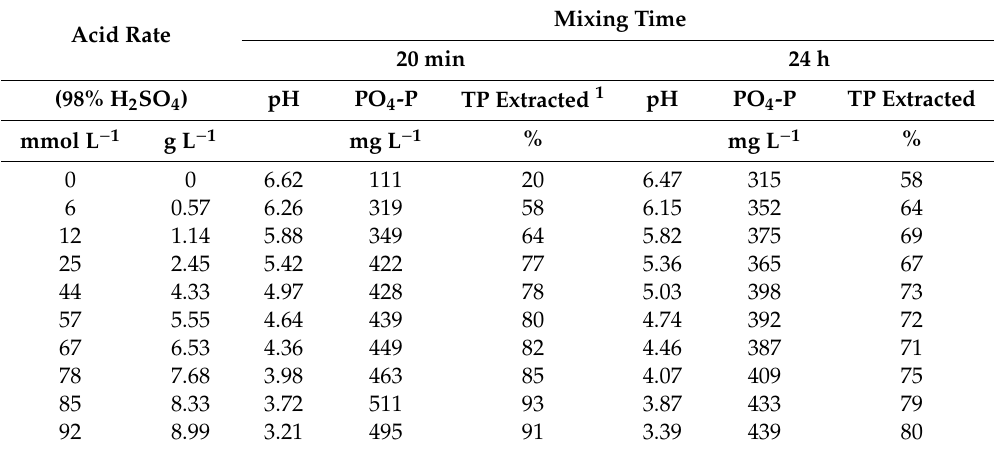
Table 1. E ff ect of acid addition and mixing time on extracted phosphorus from dairy manure. Mixing Time Acid Rate 20 min 24